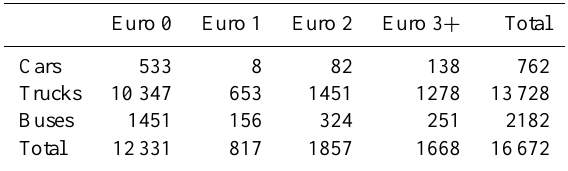
Table 9. PM 2 . 5 , BC and OC emissions in the Murmansk Region, 2012 (t).